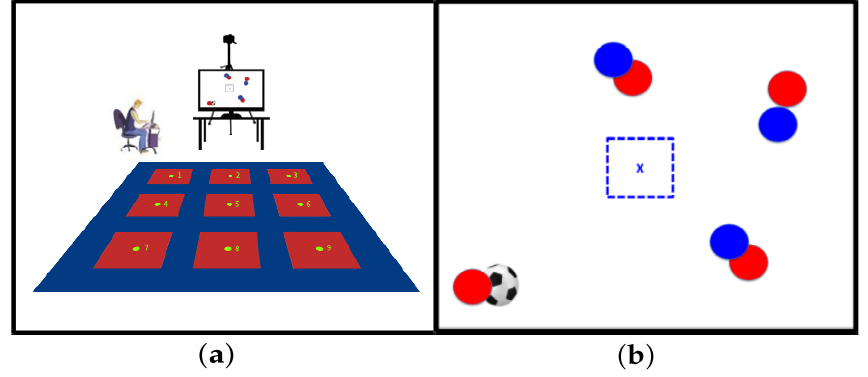
Figure 1. Training platform and visual stimulus presented to a team sport player. ( a ) Training platform with nine red square targets. ( b ) Visual stimulus of soccer tactical situation